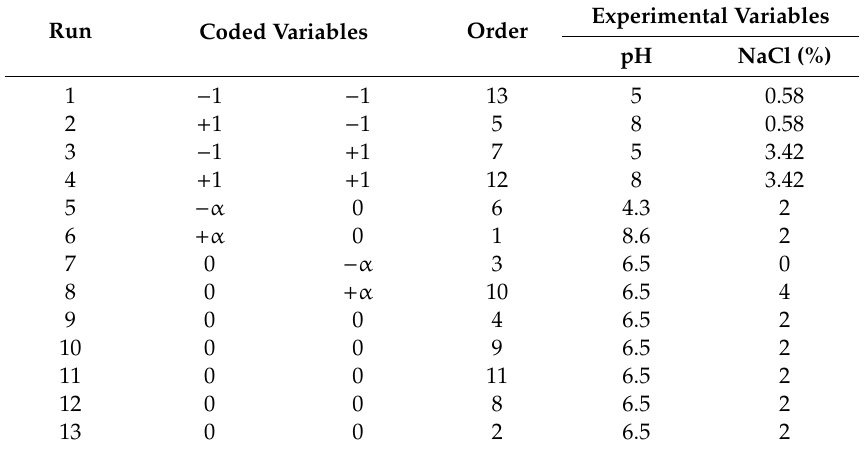
Table 1. Experimental design for the optimization of the recovery technofunctional protein extracts from porcine hearts, according to the central composite design (CCD). Experimental Variables Run Coded Variables Order pH NaCl (%) −